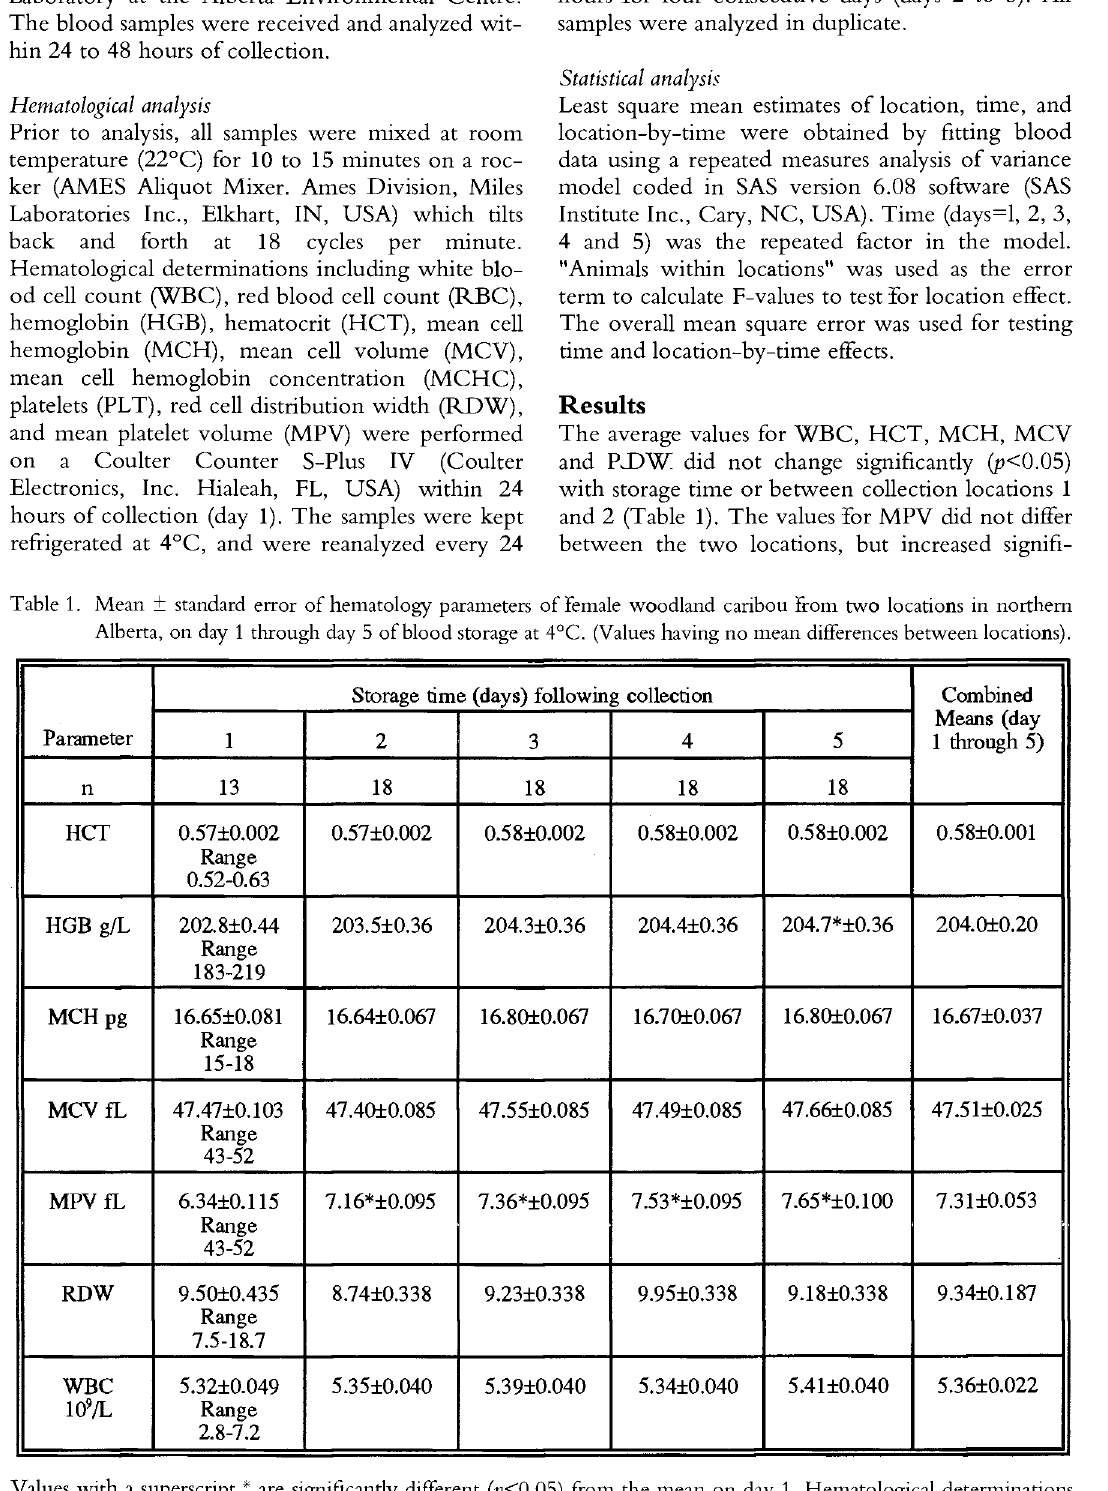
Table 1. Mean ± standard error of hematology parameters of female woodland caribou from two locations in northern Alberta, on day 1 through day 5 of blood storage at 4°C. (Values having no mean differences between locations).